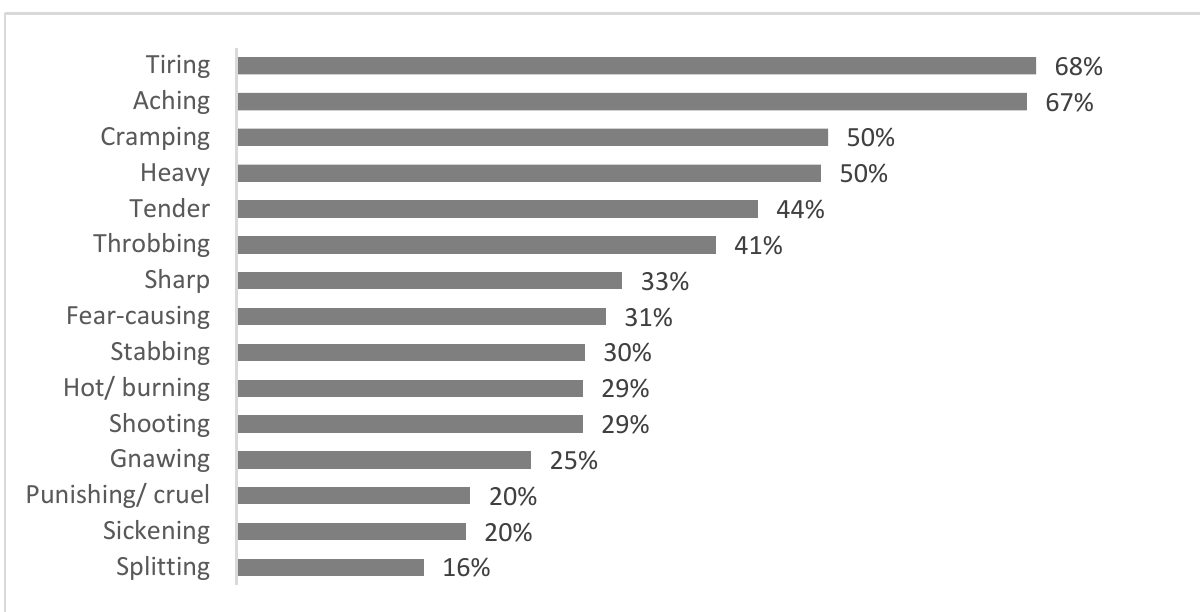
Figure 4. Percentage of individuals reporting each pain descriptor.